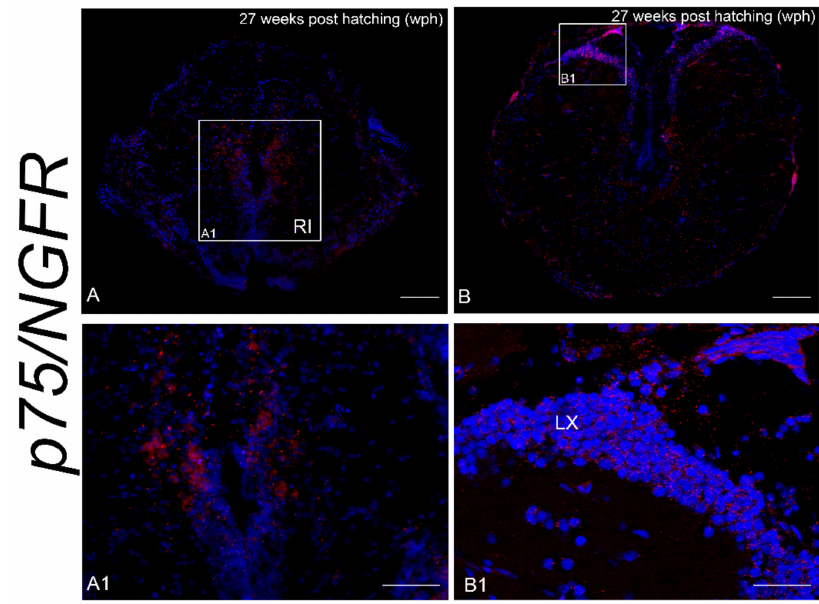
Figure 6. p75 / NGFR mRNA in the brain of young and old N. furzeri . ( A ). Transverse section of medulla oblongata of young animals showing intense staining in neurons of the caudal reticular formation, around the caudal part of ventricle / anterior margin of ependymal canal. ( A1 ) Higher magnification of rectangle in ( A ) depicting p75 / NGFR expressing neurons located along the rhomboencephalic ventricle / rostral part of ependymal canal. ( B ) Transverse section of medulla oblongata of old animals showing labeling in neurons of the vagal lobe and along the ventricle. ( B1 ) Higher magnification of rectangle in ( B ) depicting p75 / NGFR expressing neurons in the vagal lobe. Scale bars = A, B = 2.5 µ m; A1 = 50 µ m; B1 = 100 µ m.